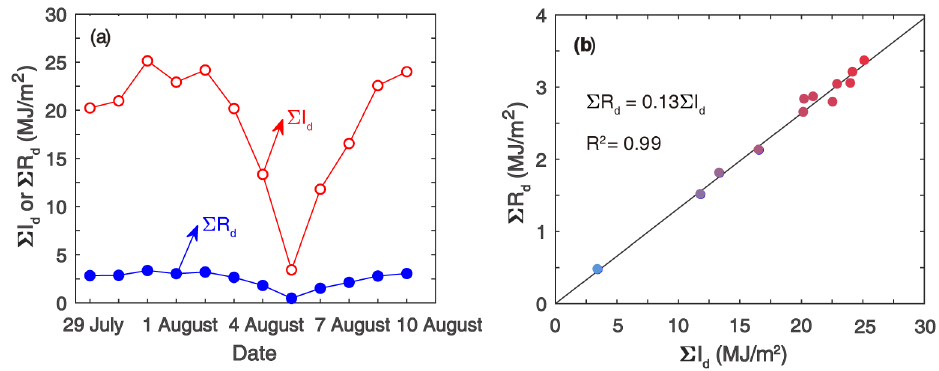
Figure 3. I d and Σ R d . ( a ) Daily cumulative solar radiation and reflected solar radiation, ( b ) Σ I d correlates well with Σ R d , meaning that the grassland had an albedo of 0.13.